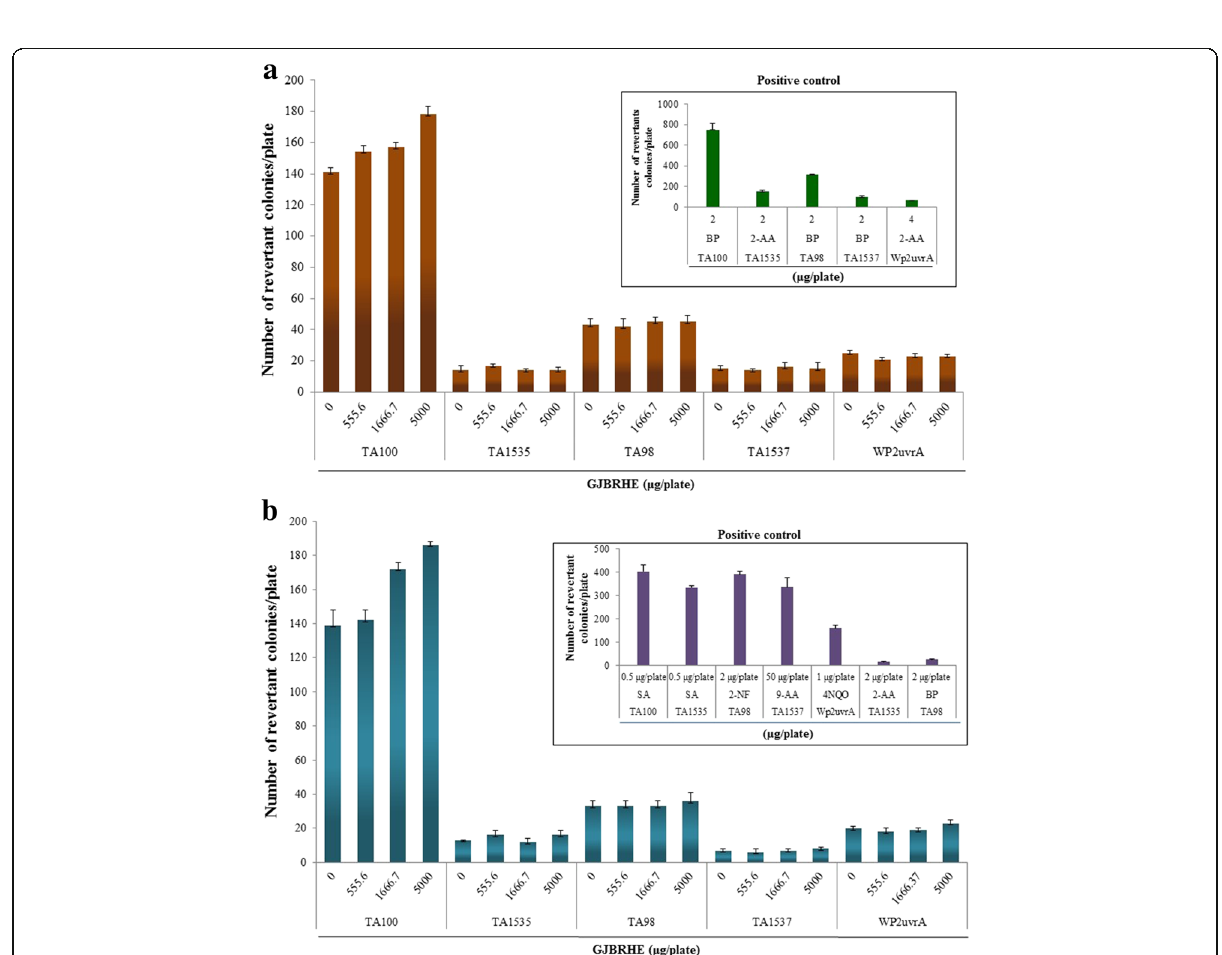
Fig. 3 Effects of GJBRHE in the bacterial reverse mutation assay (Ames test) ( a ) in the presence of (+S9 fraction) and ( b ) in the absence of ( – S9 fraction) metabolic